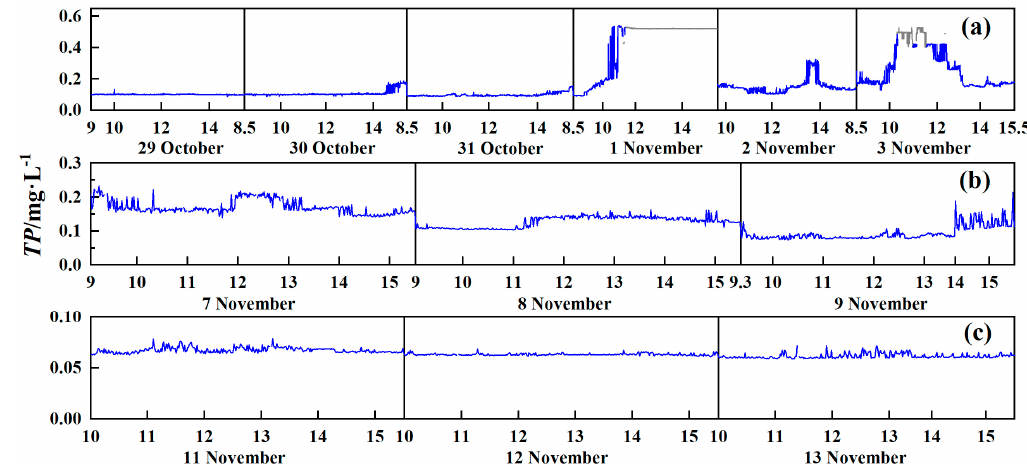
Figure 3. Time series of TP derived from the GHPSs and XGboost TP estimation model in Lake Taihu ( a ) from 29 October to 3 November 2020; Liangxi River ( b ) during 7–9 November 2020 and Fuchunjiang Reservoir ( c ) during 11–13 November 2020. Note the data of the grey represent the abnormal data with NDVI values above 0.4, which are not used for statistics and calculation.